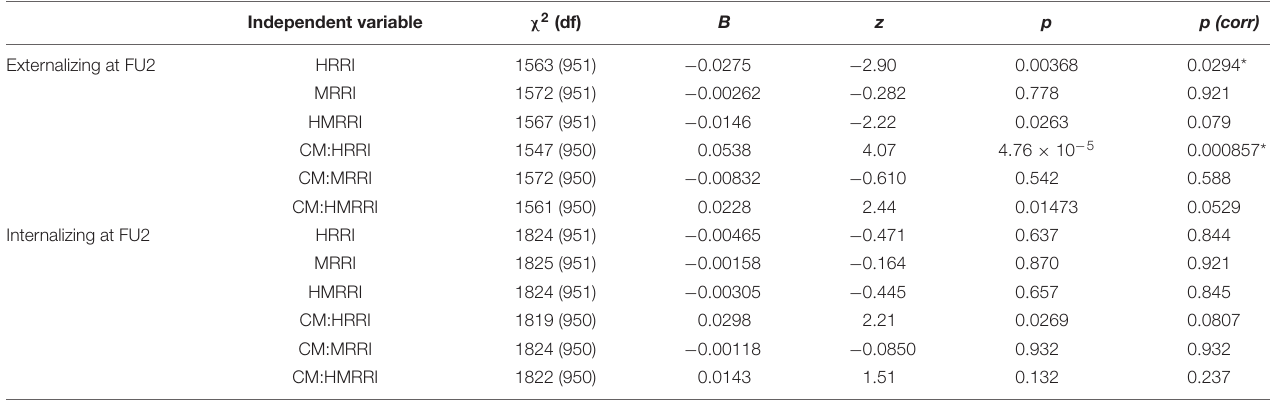
TABLE 3 | Correlations between Externalizing and Internalizing Score (SDQ) at age 18 and the genetic scores. Independent variable χ 2 (df) B z p p